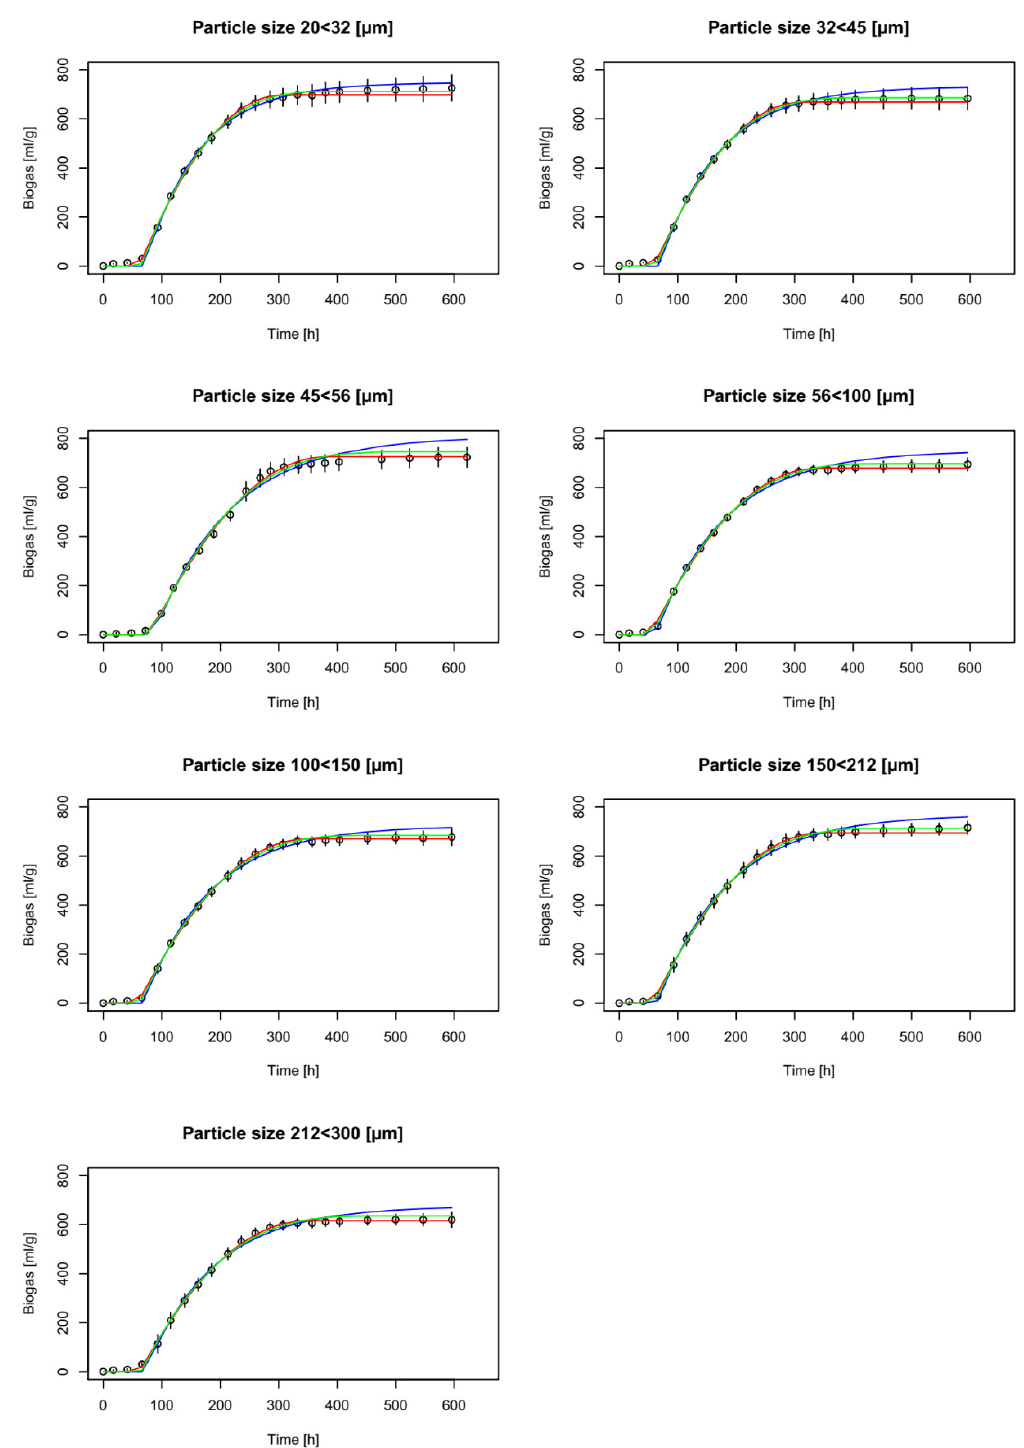
Figure 2. Biogas production experimental and model data for each sample. Circles denote the means of three samples, and vertical bars denote standard deviations. Blue, red, and green lines denote the first-order kinetic model and the approximations for the cylindrical and spherical particles, respectively.